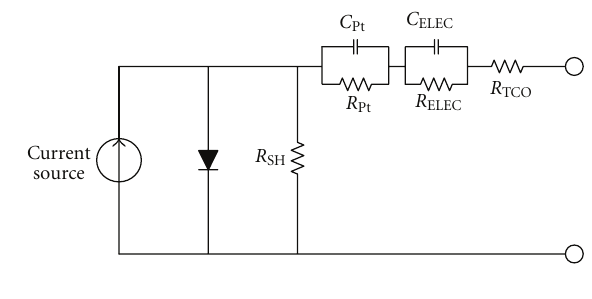
Figure 1: An equivalent circuit of a DSSC.